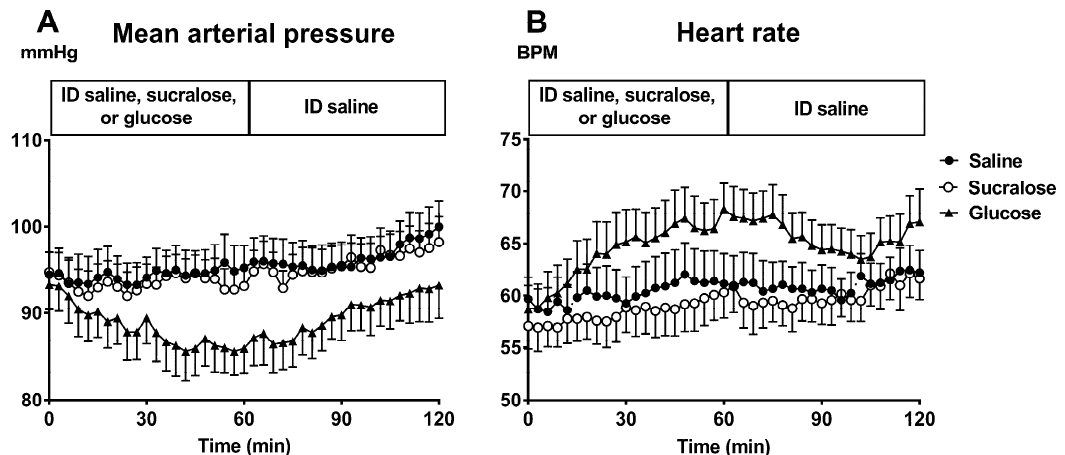
Figure 4. ( A ) Mean arterial pressure (MAP) and ( B ) Heart Rate in 12 healthy older subjects after intraduodenal (ID) infusion of glucose ( ▲ ), sucralose ( ο ), and saline ( • ). Values are means ± SEM. MAP: p < 0.05 for glucose compared with sucralose or saline, and p = 1.0 for sucralose compared with saline. Heart rate: p < 0.05 for glucose compared with sucralose, p = 0.07 for glucose compared with saline, and p = 1.0 for sucralose compared with saline [78].